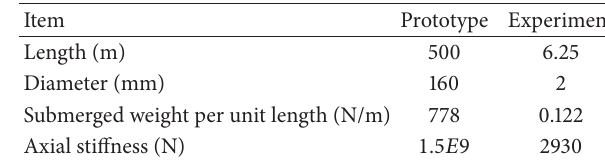
Table 1: Physical properties of mooring